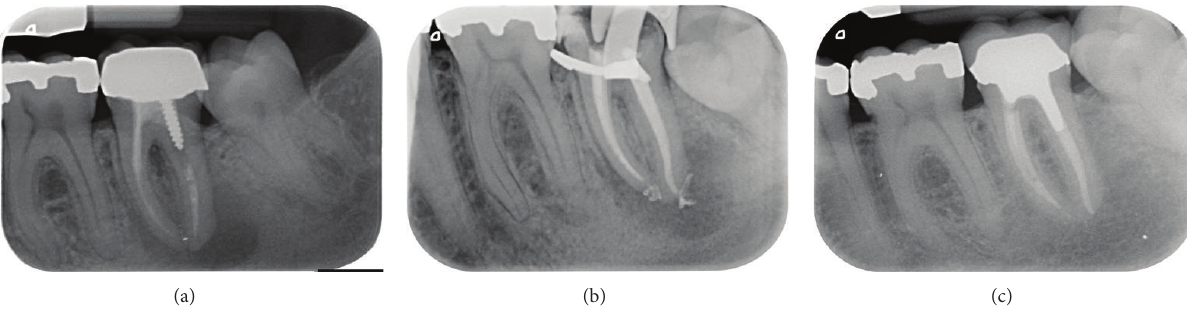
Figure 2: Case classified as healed. (a) Preoperative view of the 37, painful, with failure of an initial endodontic treatment performed more than one year ago. Note the apical radiolucency (PAI = 5 ). (b) Periapical X-ray control immediately after the endodontic retreatment. (c) Recall after 4 years. Note the disappearance of the apical radiolucency. This tooth is classified as “healed”: disappearance of pain and functional and asymptomatic tooth with complete healing of periapical